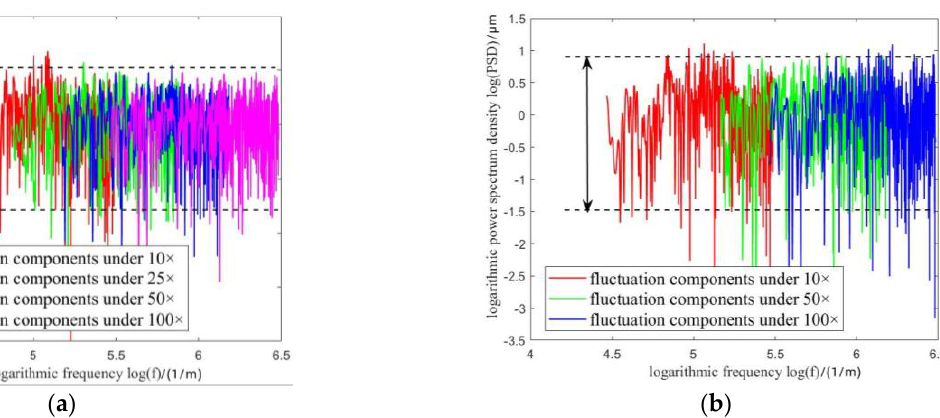
Figure 12. Fluctuation components of WC-Ni surface under different scales. ( a ) WC-Ni surface; ( b ) 9Cr18Mo surface. Table 7. Detailed values of fluctuation components in WC-Ni surfaces.